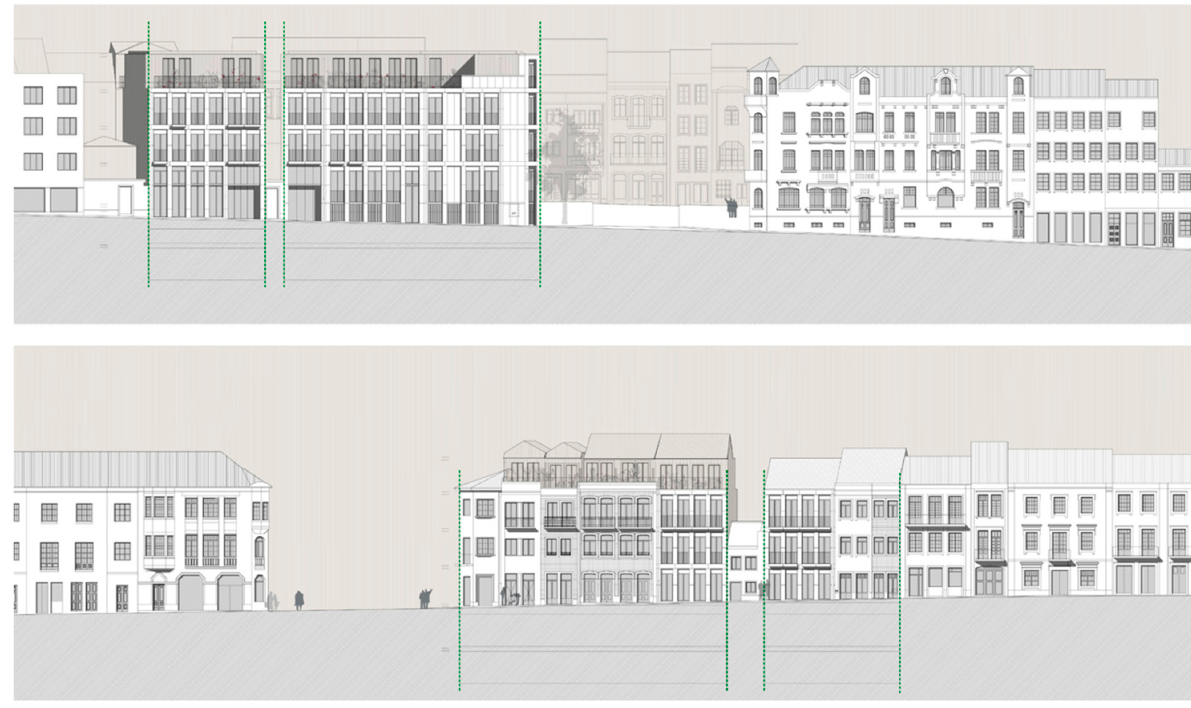
Figure 13. Braga. Sections.